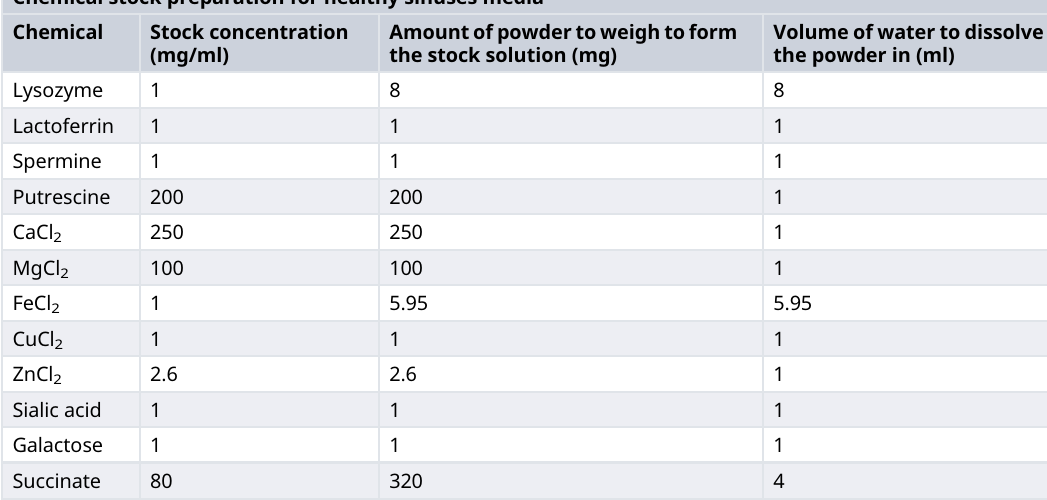
Table 9. Preparation of chemical stocks for healthy sinuses